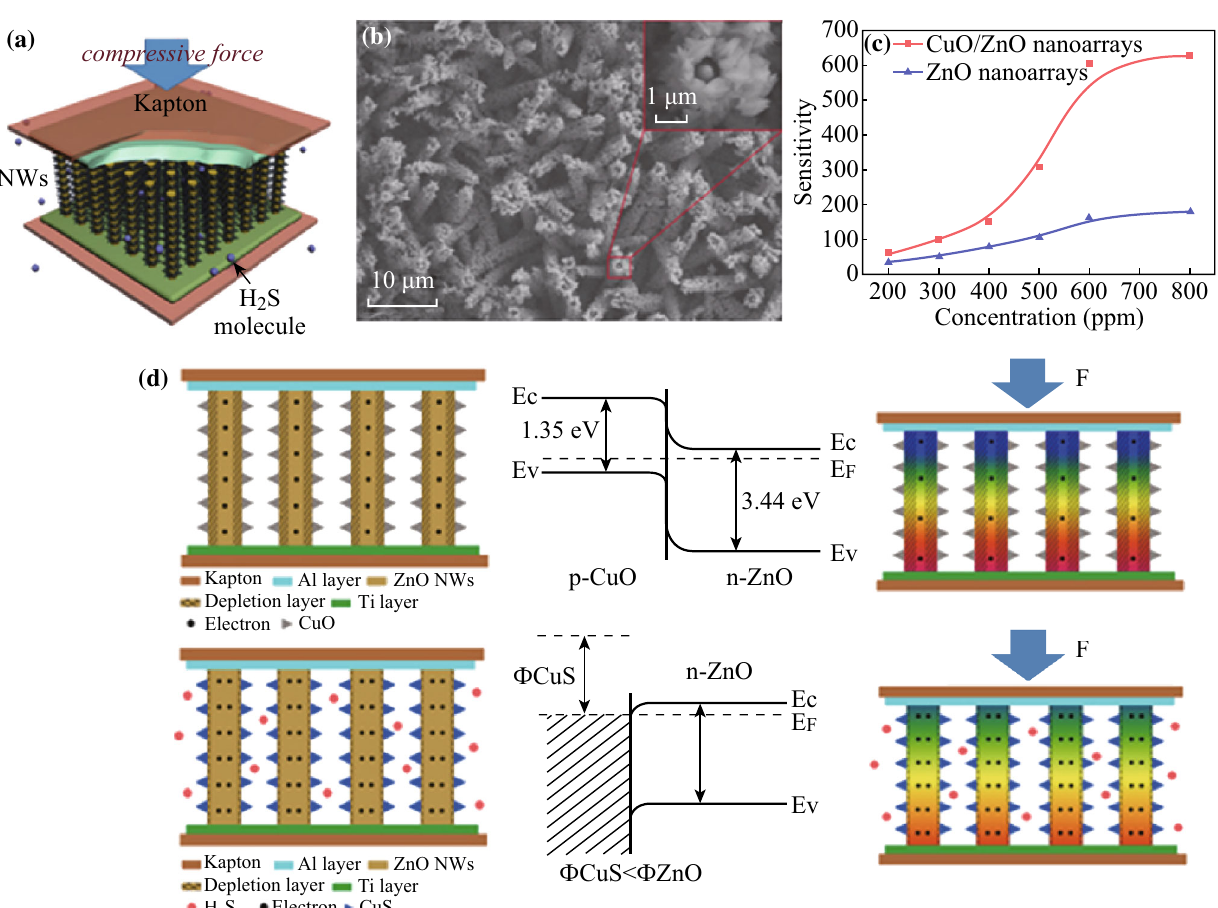
Fig. 4 Conversion of PN junction influencing the piezoelectric output of a CuO/ZnO nanoarray PENG and its application as a room-temperature self-powered active H 2 S sensor. a Schematic diagram showing the structure of the self-powered active gas sensor with two Kapton boards as the frame. b SEM image of CuO/ZnO nanoarrays on the top view (the inset is an enlarged view of a selected area). c The sensitivity of the device upon exposure to different concentrations of H 2 S with one device repeatedly compressed by a constant applied strain of 0.012% at a frequency of 0.8 Hz. d The H 2 S sensing mechanism of the self-powered active gas sensor based on CuO/ZnO PN-junction nanoarrays driven by compressive strain. Figures adapted from